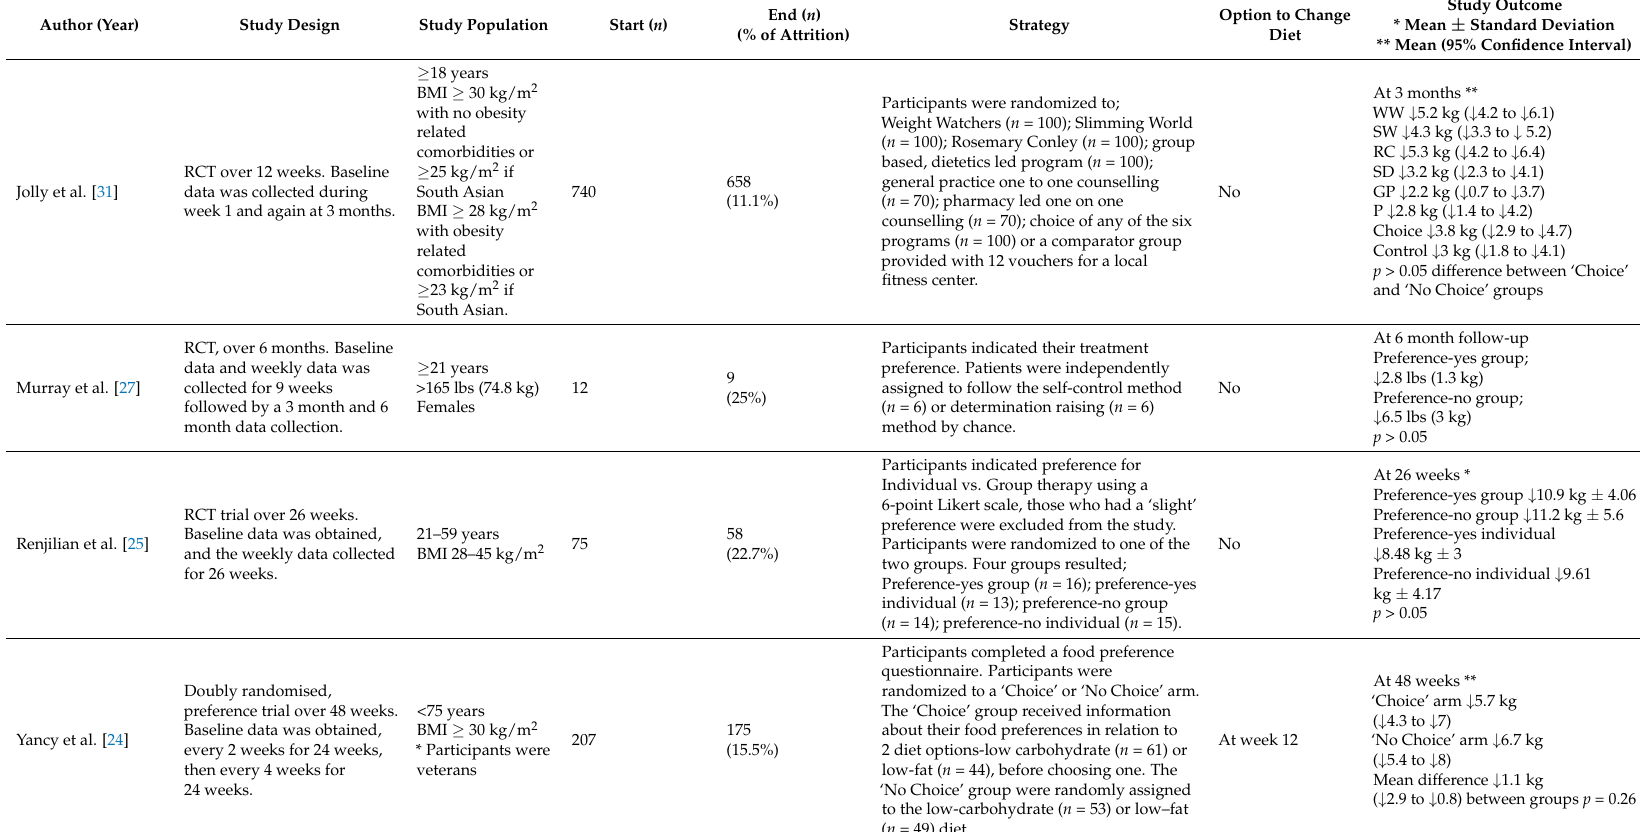
Participants indicated preference for Individual vs. Group therapy using